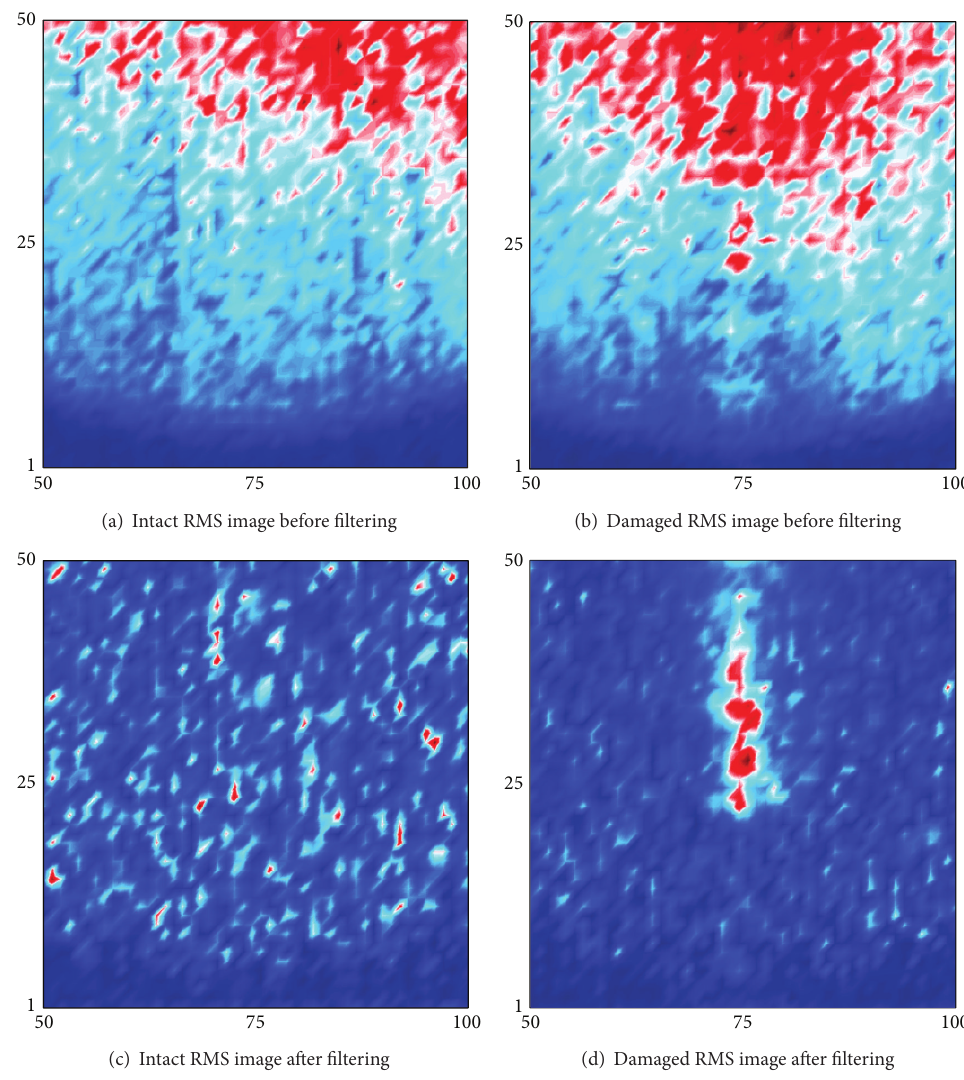
Figure 14: Comparison of RMS snapshots at 48 𝜇 s for damage case